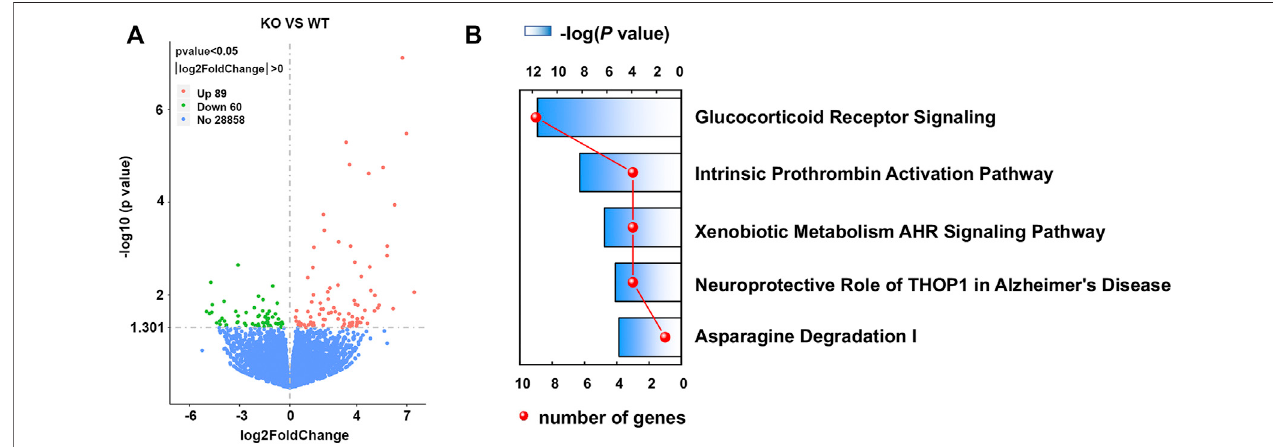
FIGURE 5 | Volcano plots of differentially expressed genes (DEGs) and top canonical pathways involved in Asrgl1 KO mice. (A) Volcano plots of DEG pro fi le. The vertical lines correspond to 2.0 FC up and down, and the horizontal line represents − log 10 ( P -value). (B) Ingenuity pathway was used to analyze the total signi fi cantly differentially expressed genes and identify the canonical pathways involved in Asrgl1 KO mice. The top fi ve signi fi cant pathways identi fi ed were displayed (blue bar). The red curve shows the total number of genes in each of these pathways.